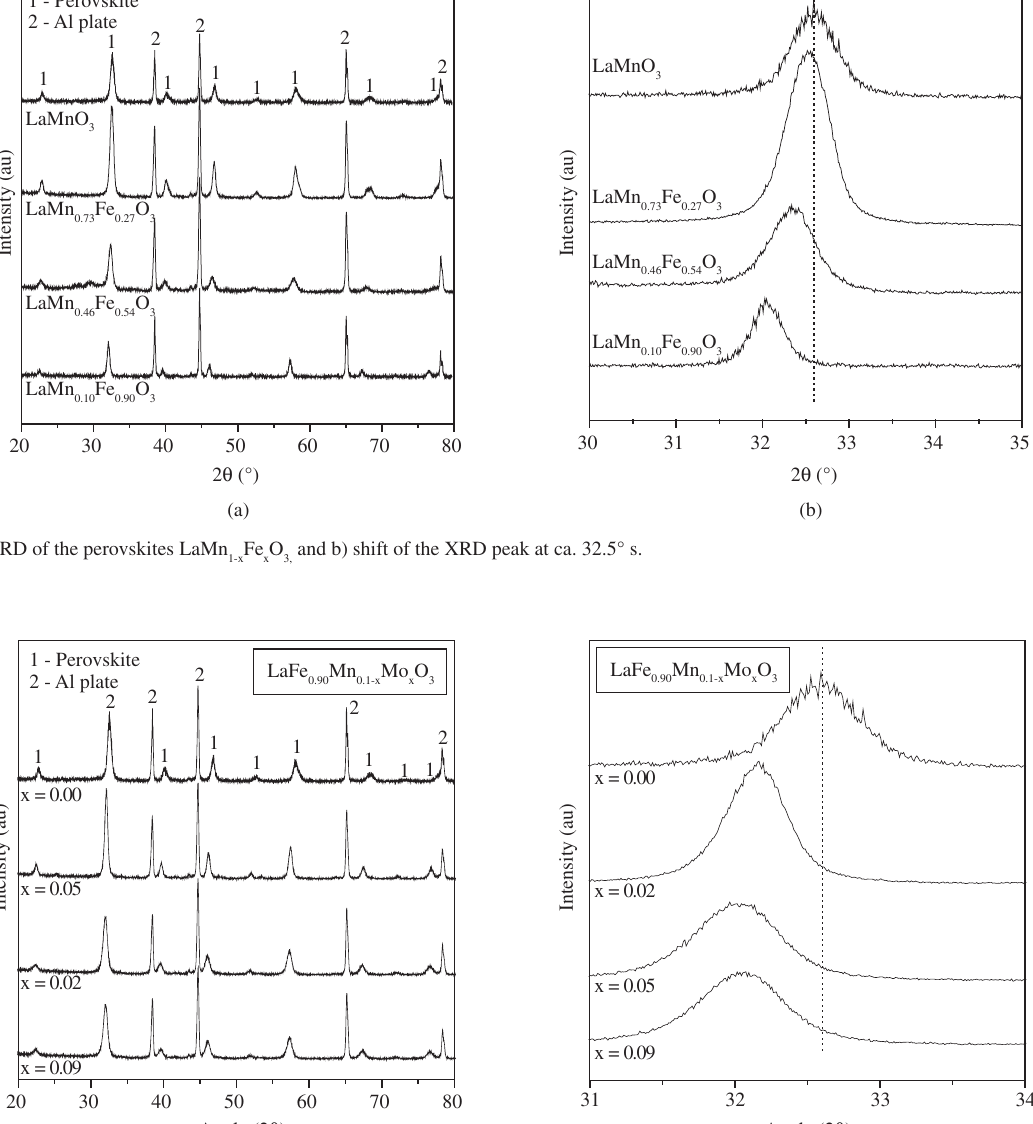
Fe Mo O perovskites, and b) shift of the y x z 3